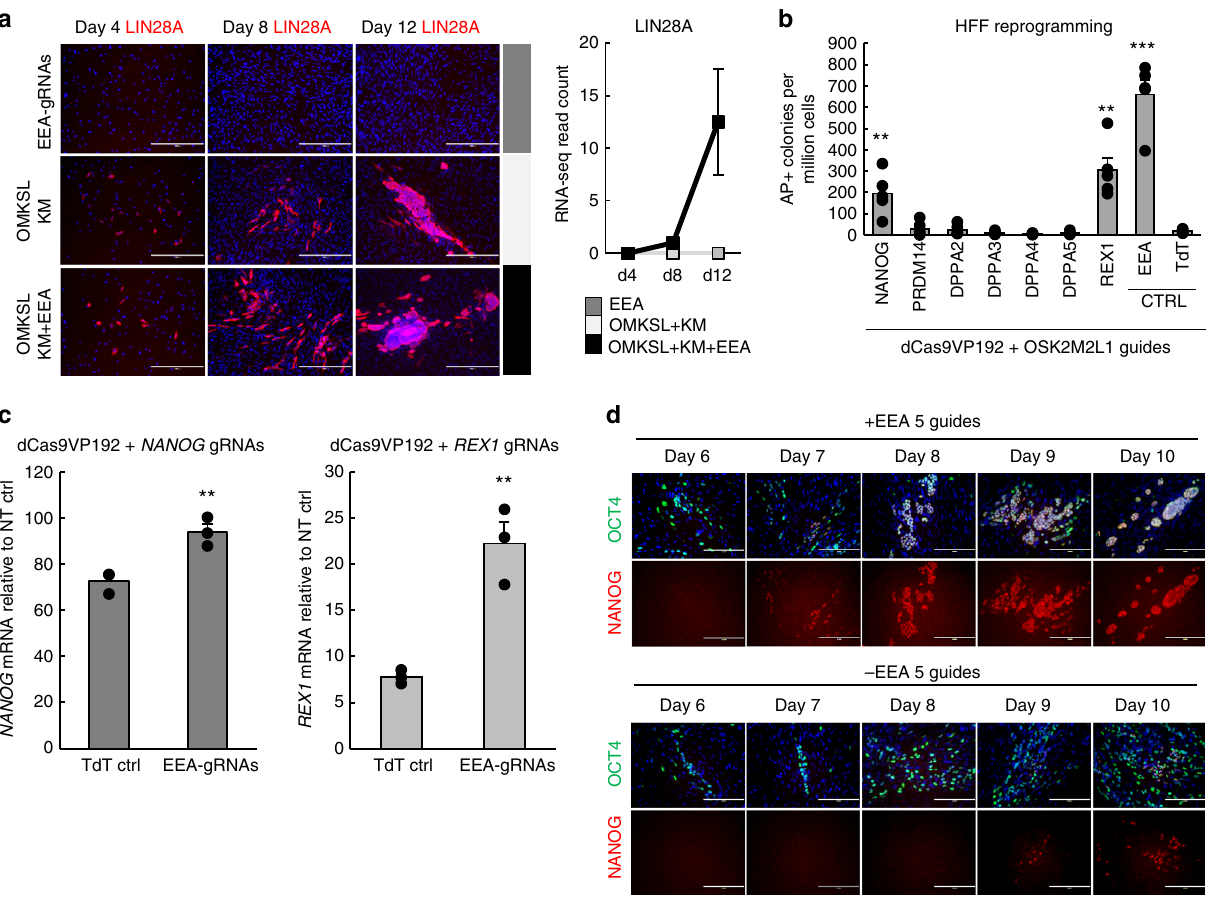
Fig. 5 EEA-motif targeting improves NANOG and REX1 activation. a Immunostaining of emerging iPSC colonies detects activation of targeted LIN28A before its mRNA reads become detectable in bulk RNA-seq. Scale bar = 400 µ m. b HFF reprogramming ef fi ciency after transgenic expression of additional factors belonging to Group 6 (Fig. 4c). n = 5, three independent experiments. c qRT-PCR quanti fi cation of NANOG and REX1 activation using dCas9VP192 with and without EEA-motif gRNAs in HEK293. n = 3, three independent experiments. d NANOG activation can be detected by immunostaining in CRISPRa reprogramming colonies 2 days earlier in the presence of EEA-motif targeting guides. Scale bar = 200 µ m. Data presented as mean ± s.e.m., two